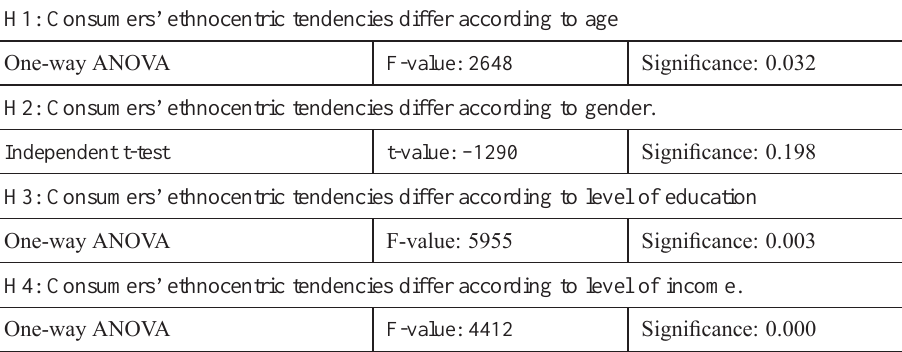
Table 2. Testing of Hypotheses